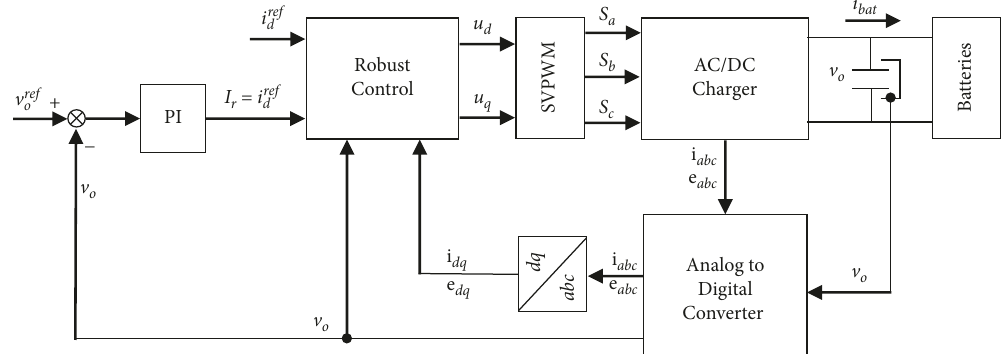
Figure 2: Block diagram of CV mode